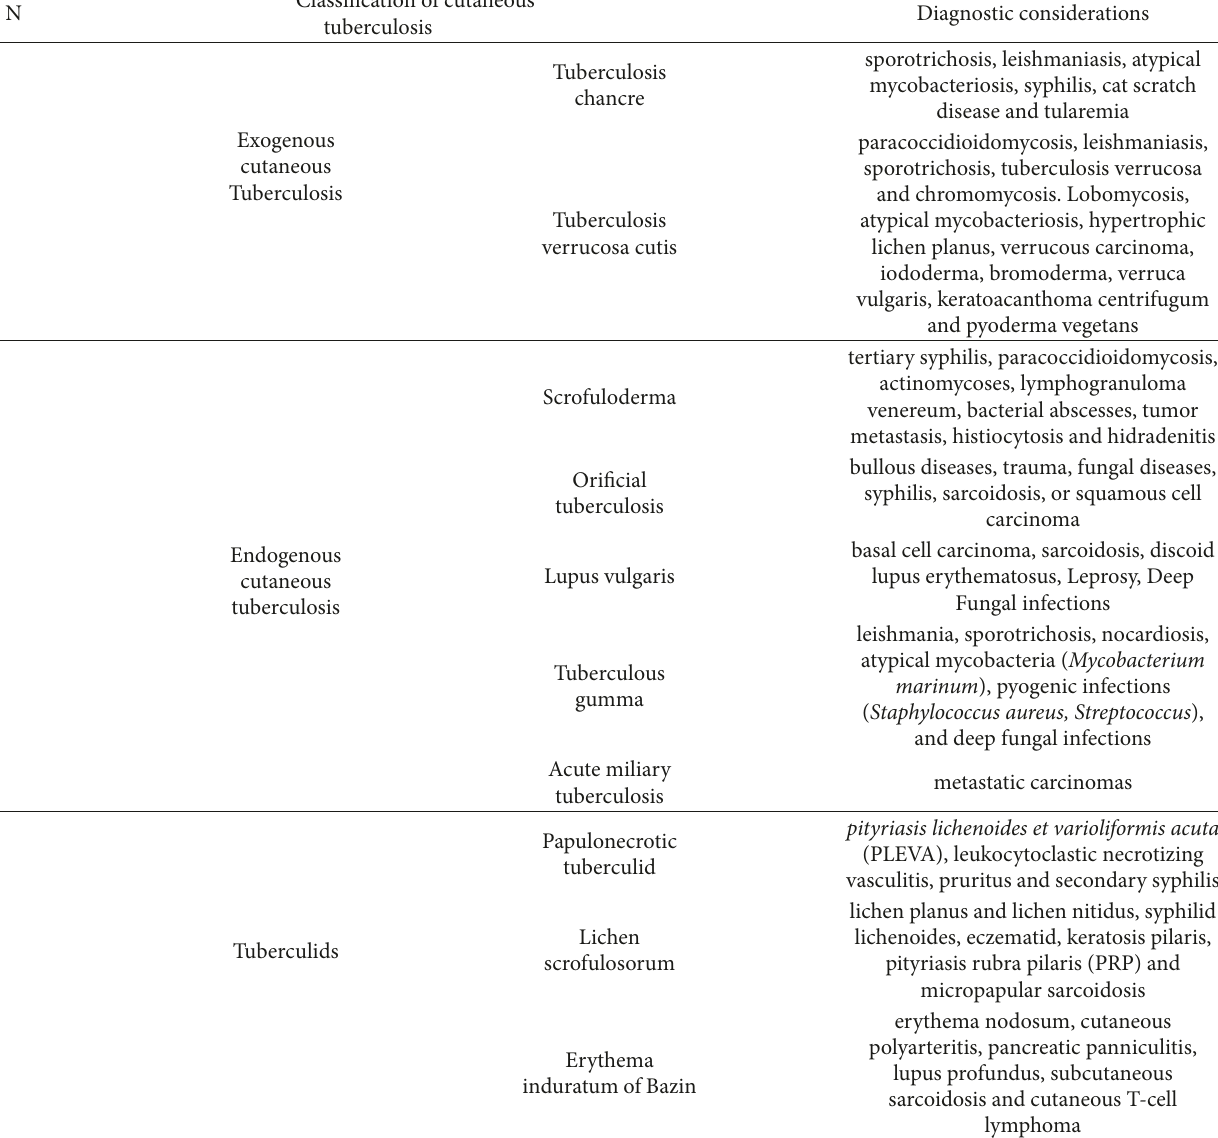
Table 1: Clinical manifestations of cutaneous tuberculosis and its differential diagnosis. S. N